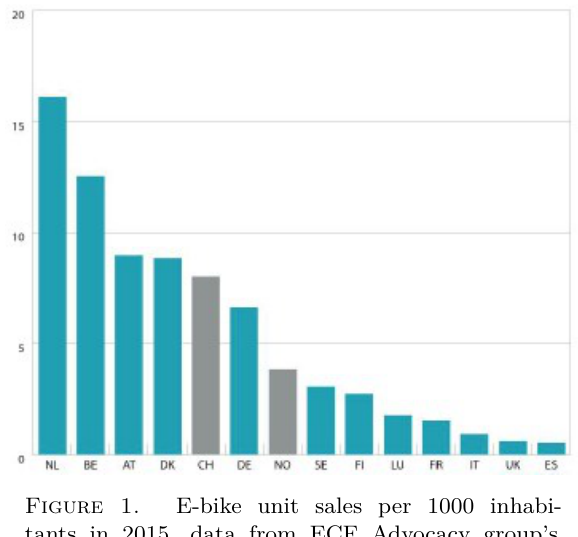
Figure 1. E-bike unit sales per 1000 inhabi- tants in 2015, data from ECF Advocacy group’s